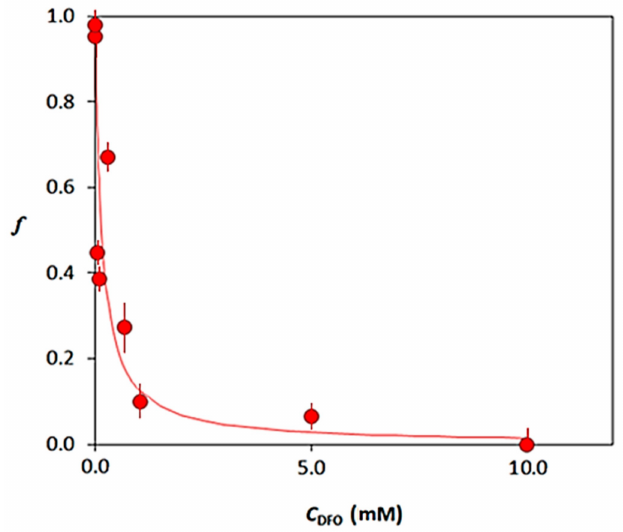
Figure 6. Desorption profile of Fe(III) from Fe(III)-DFO@EVOH, at pH 7, as a function of the DFO concentration added in solution. Discontinuous procedure. Solid phase: Fe(III)-enriched DFO@EVOH (circular clips 3.5 mg); solution phase: PIPES bu ff er 0.1 M at pH 7, V = 1.5 mL. Error bars represent the standard deviation on three